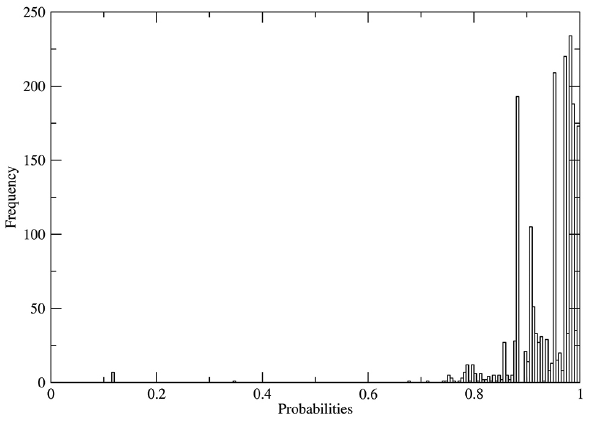
Figure 6. Prediction probabilities histogram of test set